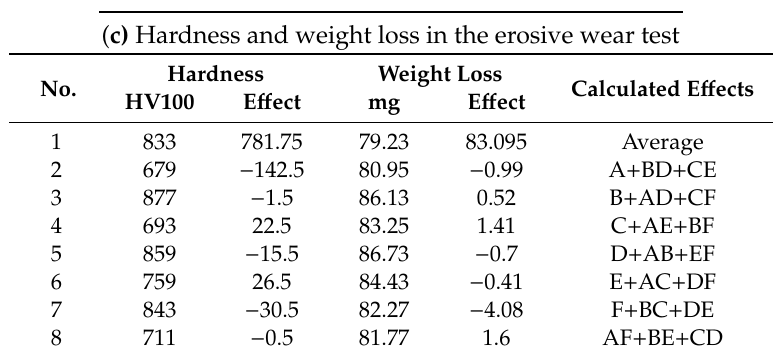
( c) Hardness and weight loss in the erosive wear